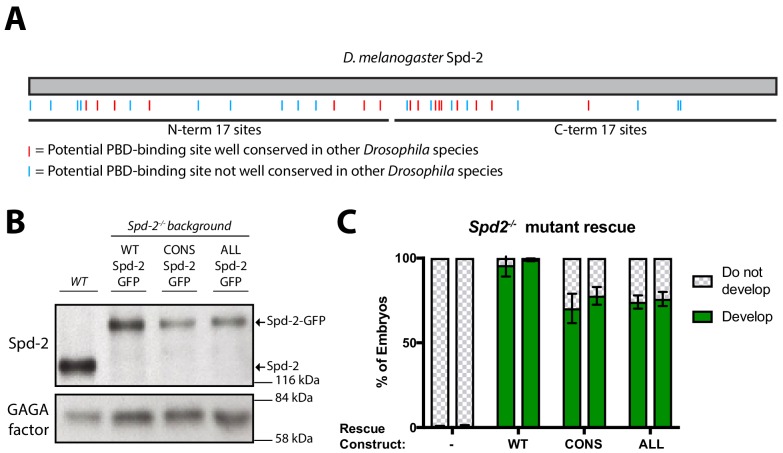
Generating forms of Spd-2 that should be unable to bind the PBD.(A) A schematic representation of Drosophila melanogaster Spd-2, indicating the position of S-S/T motifs that are either highly conserved (present in at least 11/12 Drosophila species analysed—red lines), or not highly conserved (blue lines). (B) Western blot of WT embryos, or Spd-2 mutant embryos expressing either WT Spd-2-GFP, Spd-2-CONS-GFP or Spd-2-ALL-GFP, as indicated, probed with either anti-Spd-2 antibodies or anti-GAGA transcription factor antibodies (Raff et al., 1994) (as a loading control). The blot shown is representative of three technical replicates. (C) Bar charts quantify the percentage of Spd-2 mutant embryos that had initiated development after expression of either WT Spd-2-GFP, Spd-2-CONS-GFP or Spd-2-ALL-GFP, as indicated. The chart shows the data from two independent biological repeats in which 3 lots of >50 embryos were collected and scored independently; error bars represent the standard deviation (SD).10.7554/eLife.50130.010Figure 2—source data 1.Figure 2A, Figure 2—figure supplement 1 source data; Spd-2 sequence alignment.10.7554/eLife.50130.015Figure 2—source data 2.Figure 2C source data, quantification of pronuclear arrest.